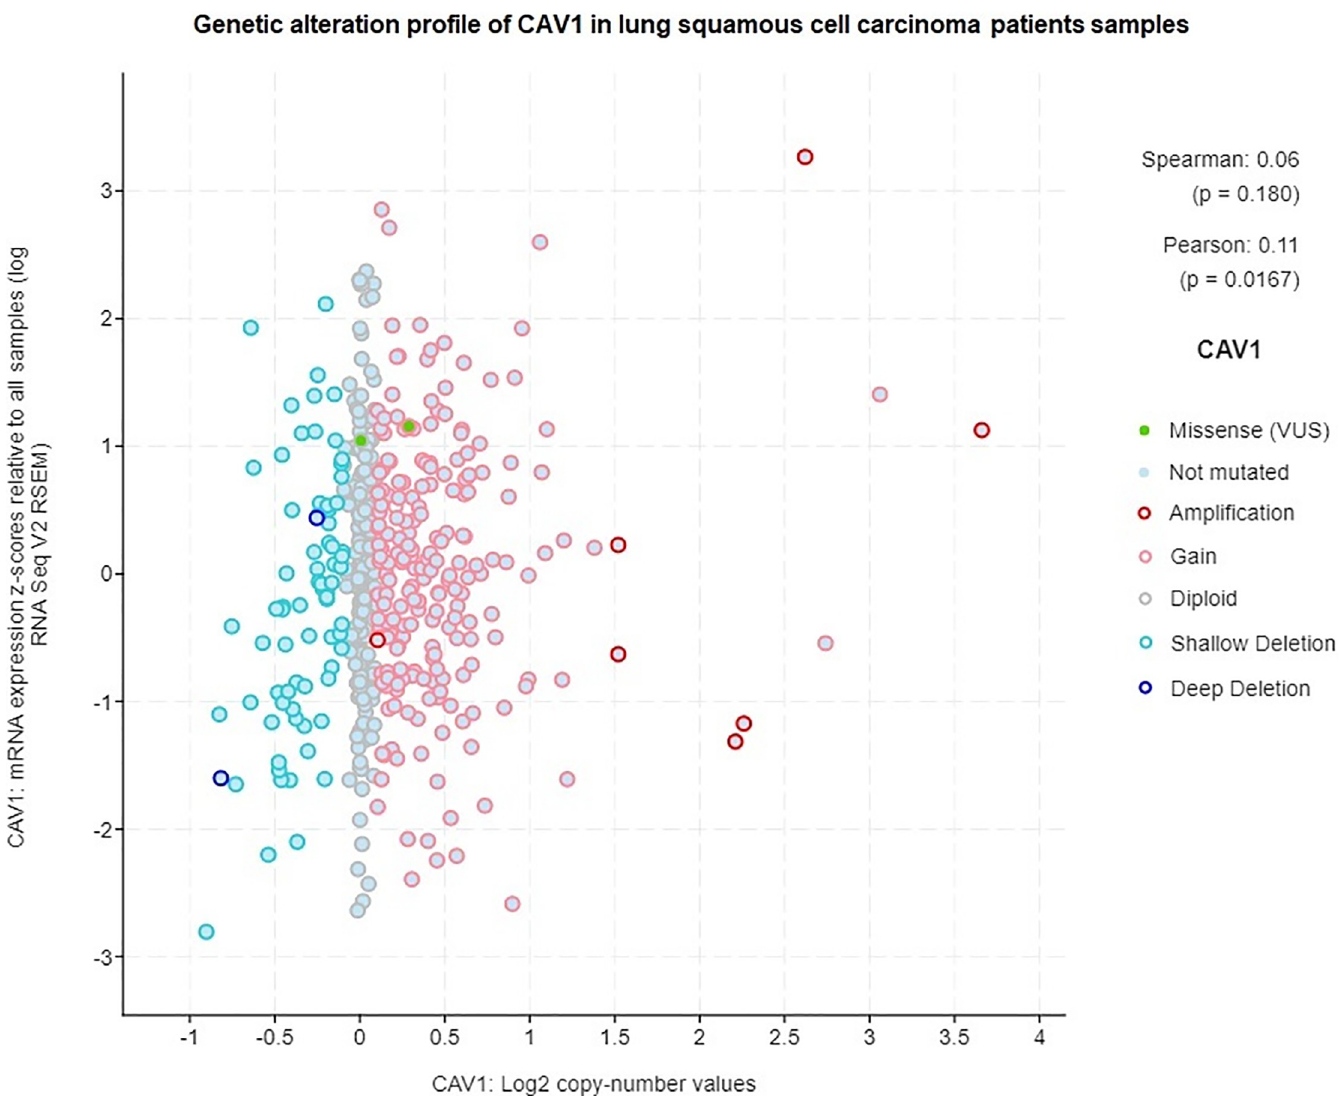
Fig 7. Genetic alteration profile of CAV-1 in lung squamous cell patient’s